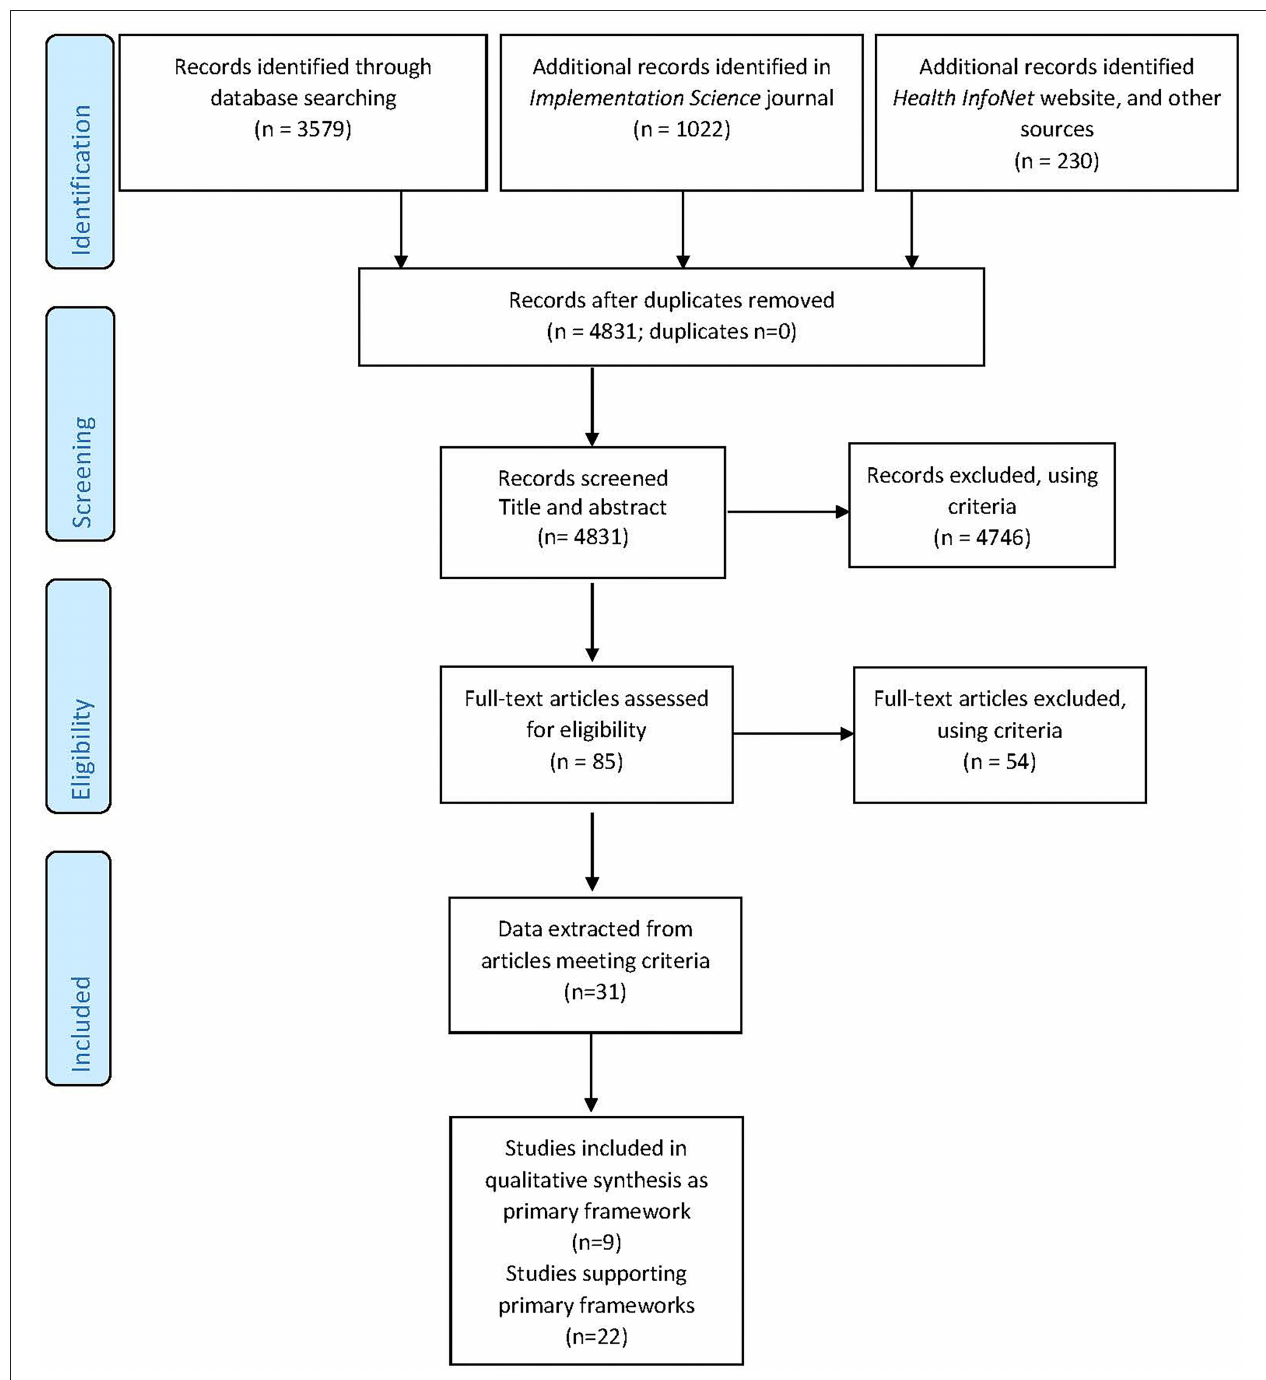
FIGURE 2 | PRISMA-ScR flow diagram